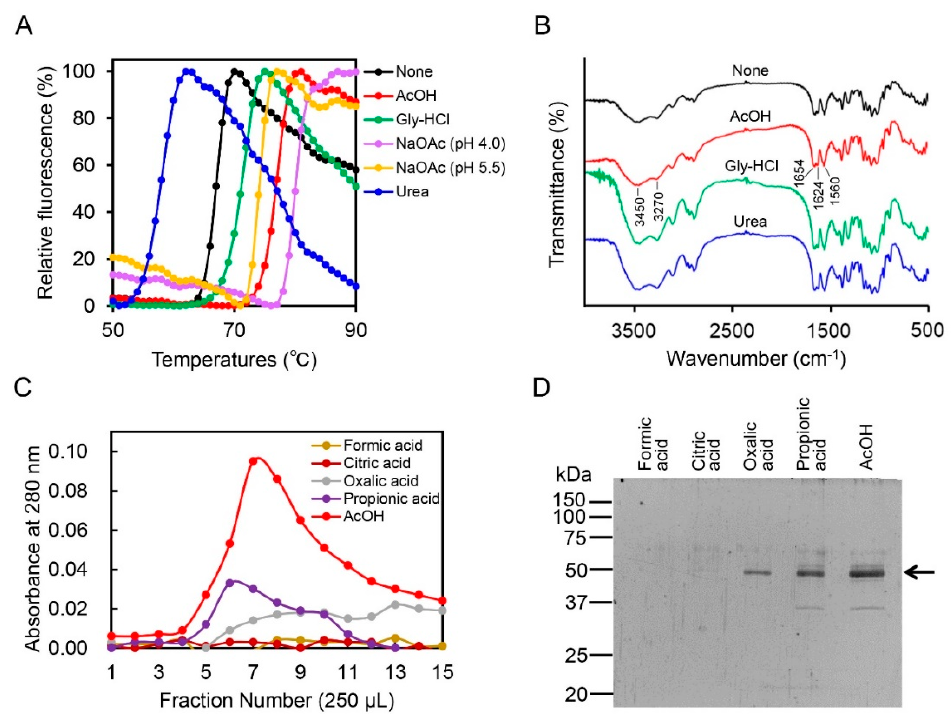
Figure 2. Evaluation of Chia-chitin dissociation by effects of Gly-HCl buffer, acetic acid, sodium acetate, and urea and their effect on the enzyme and chitin structure. ( A ) DSF analysis results for Chia in the presence of 0.1 M Gly-HCl, 0.1 M acetic acid, 0.1 M sodium acetate (pH 4.0 and pH 5.5), and 4 M urea are shown. ( B ) FT-IR spectra of chitin after treatment with water (none), acetic acid (AcOH), Gly-HCl, and urea. ( C ) Elution profiles of Chia from chitin column by 0.1 M formic acid (pH 2.5), 0.1 M citric acid (pH 2.5), 0.1 M oxalic acid (pH 2.5), 0.1 M propionic acid (pH 2.5), or 0.1 M acetic acid (pH 2.8). ( D ) SDS-PAGE analysis of the protein fractions. Arrow highlights the positions of the Chia protein.